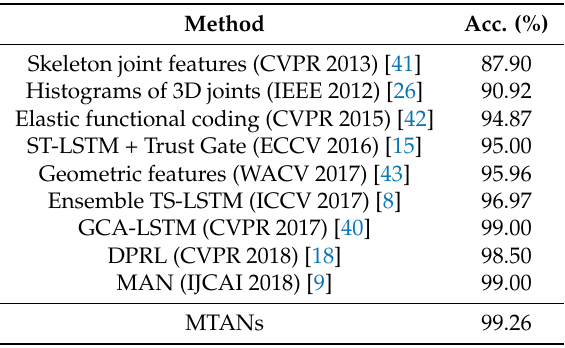
Table 8. Comparison on the UT-Kinect Action dataset in